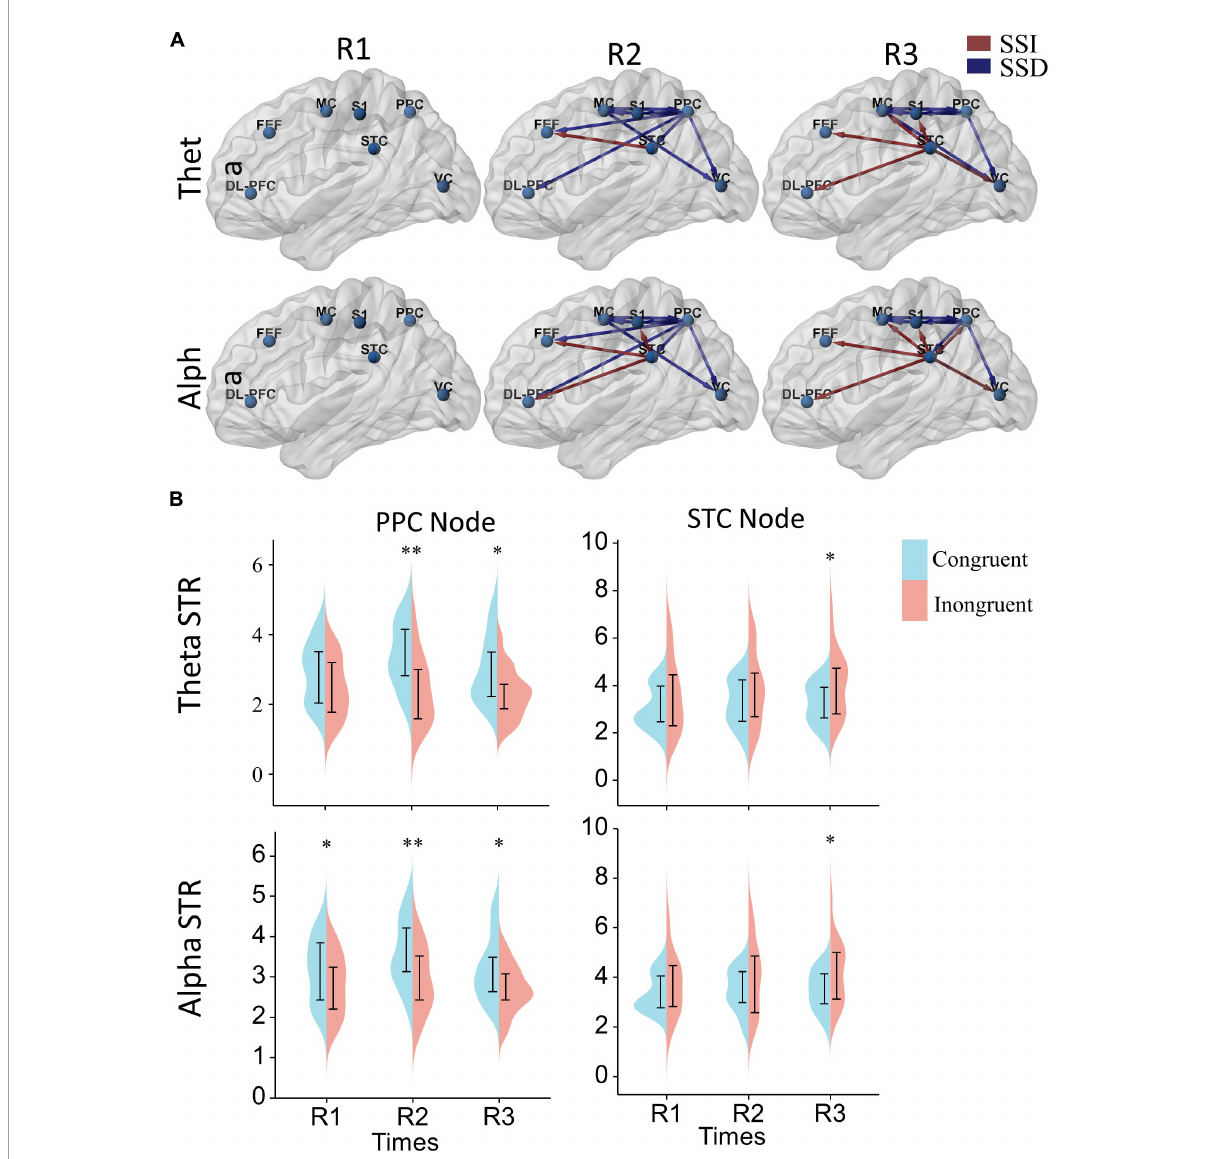
FIGURE6 The effect of sensory conflict on cortical effective connectivity networks. (A) Significant changes in effective cortical connectivity in the incongruent condition compared to the congruent condition. Red connections indicate significantly stronger connectivity in the conflict condition, and blue connections indicate significantly weaker connectivity in the conflict condition ( p < 0.05). Significance levels were calculated by paired t -test and corrected by the false discovery rate (FDR) method. The arrows represent the direction of information flow. (B) Differences in node strength (STR) in the posterior parietal and superior temporal lobes. A two-way repeated measures ANOVA with Bonferroni post-hoc tests to assess the effects of the time window and sensory condition on node strengths. ∗ p < 0.05, ∗∗ p <